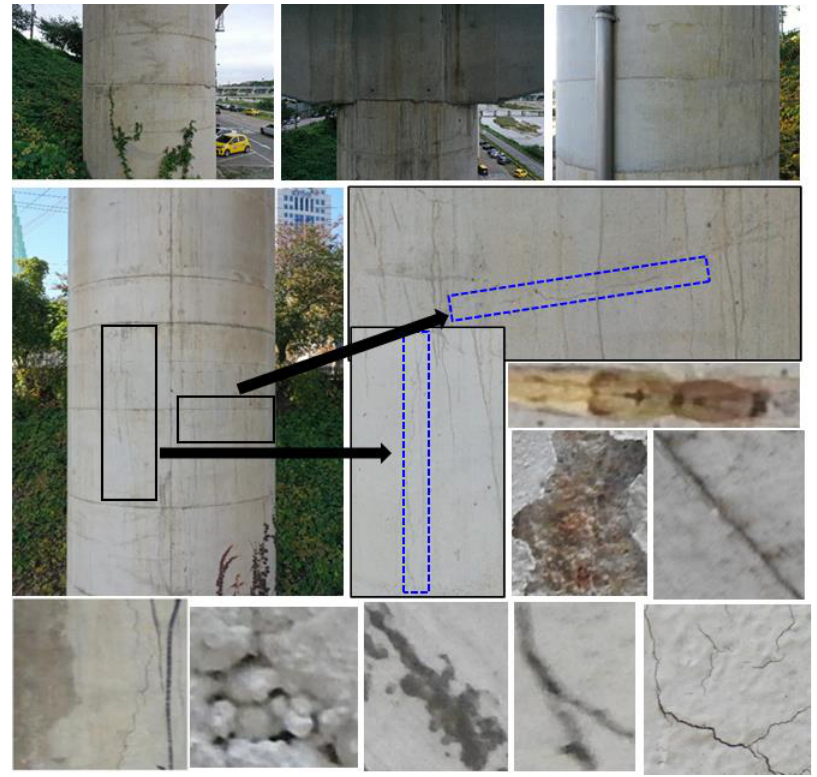
Figure A1. Representative images obtained from UAV for inspection of the bridge pier.